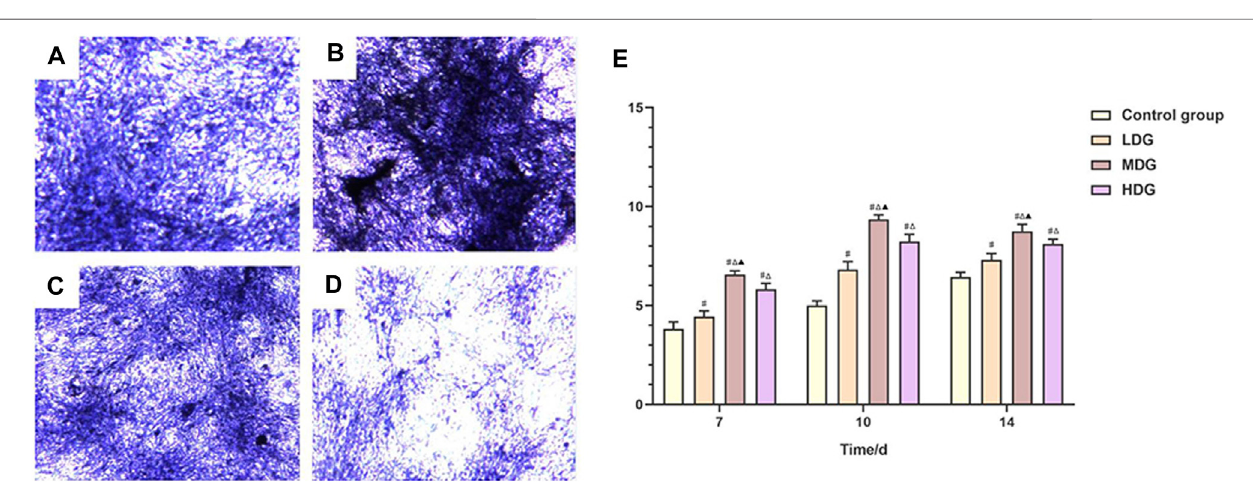
FIGURE 7 | The ALP staining assay is performed to evaluate ALP activity after incubated for 10 days (A) . TFDR low dosage group; (B) . TFDR medium dosage group; (C) . TFDR high dosage group; control group; (D) . control group (E) . The ALP activity at each time point of the control group, TFDR low dosage group, TFDR medium dosage group, and TFDR high dosage group. The data are expressed as the mean ± SEM of three independent experiments. # p < 0.05 vs. control group, Δ p < 0.05 vs. TFDR low dosage group, ▲ p < 0.05 vs. TFDR high dosage group.